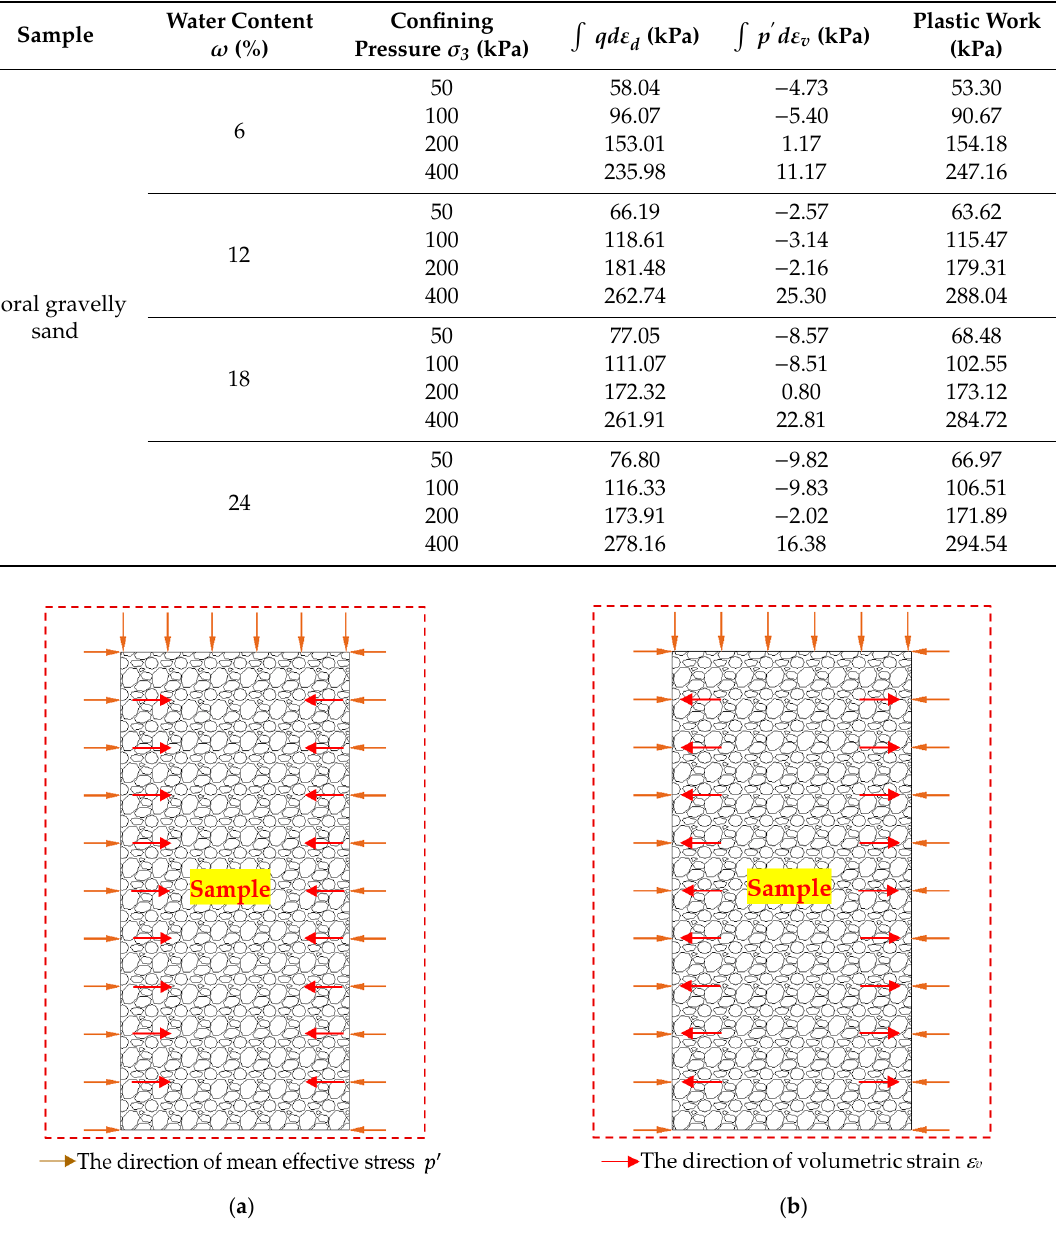
Table 5. Each component of plastic work in triaxial shear test under di ff erent test conditions.